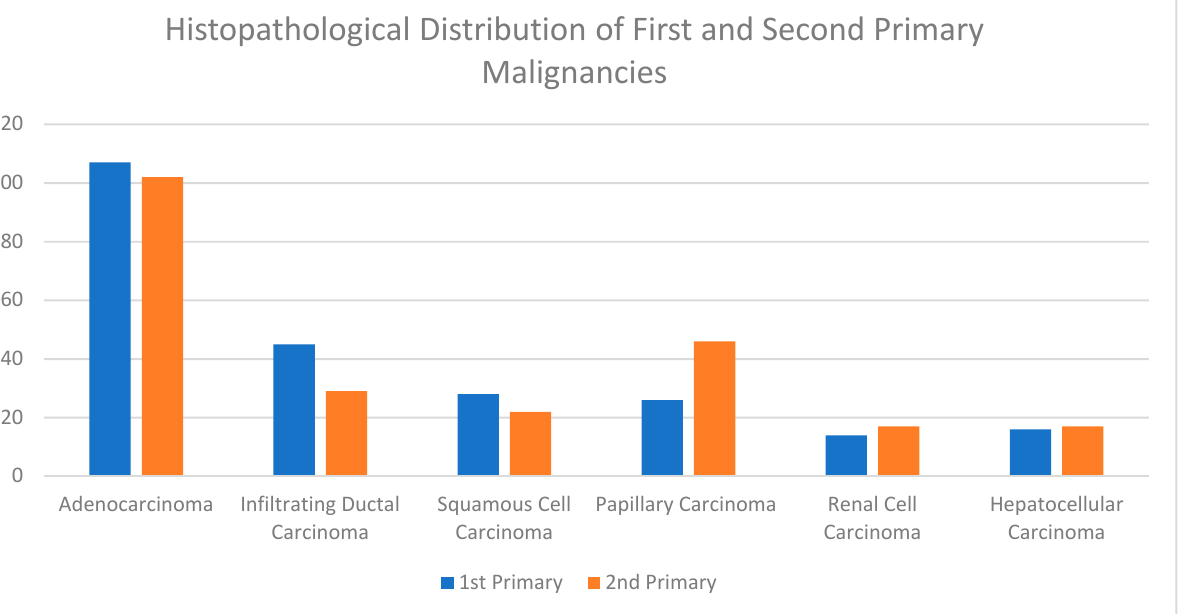
Figure 4. Shows the most frequent histopathologic morphology of the first and second primary ma- lignancies. Adenocarcinoma was the most common first primary histopathology, followed by infil- trating ductal carcinoma and squamous cell carcinoma. Adenocarcinoma was also the most com- mon second primary histopathology, followed by papillary carcinoma and ductal carcinoma. Table 2. Anatomical Distribution of Multiple Primary Malignancies and the Histopathology Based on the Time Interval between the 1st and 2nd